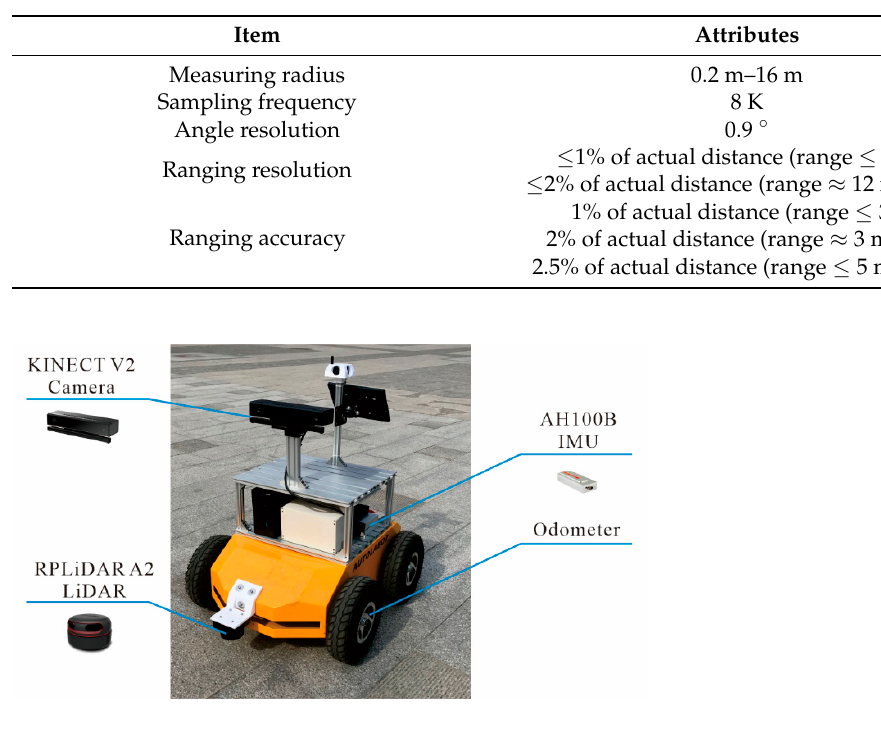
Table 3. Device parameters of Rplidar A2 LiDAR.